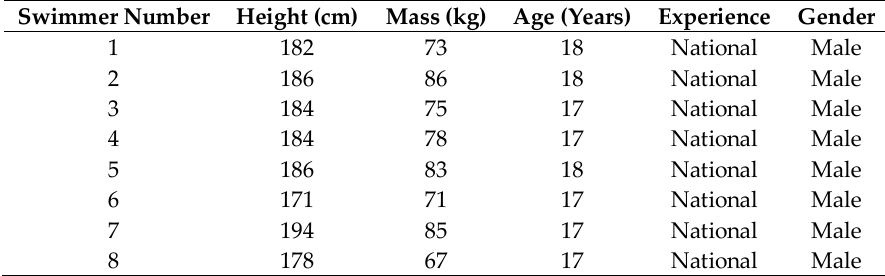
Table 1. List of participating swimmers with their height, mass, age, experience, and gender.